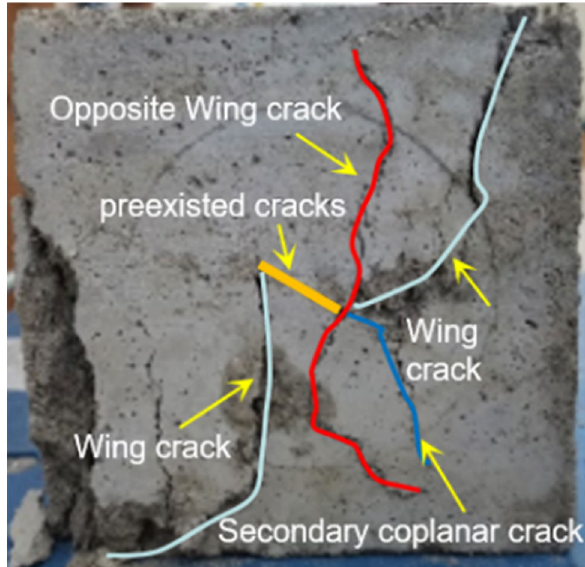
Figure 11. Fracture classification of the soft rock-like